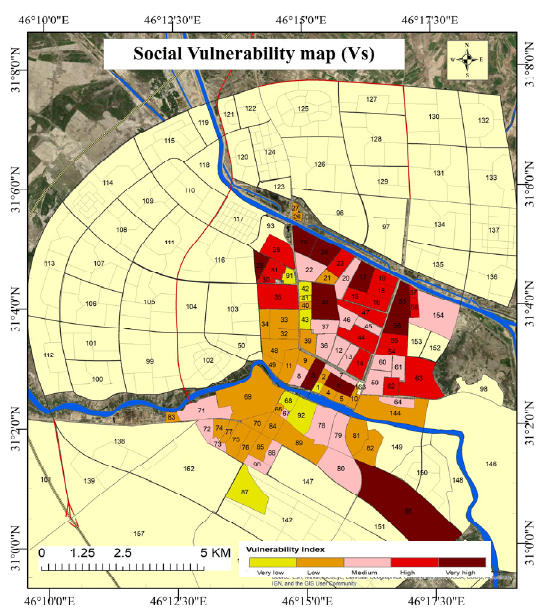
Figure 13. Sub-criteria of the social domain: ( a ) education index (C10), ( b ) health care index (C11) and ( c ) unemployment rate (C12).